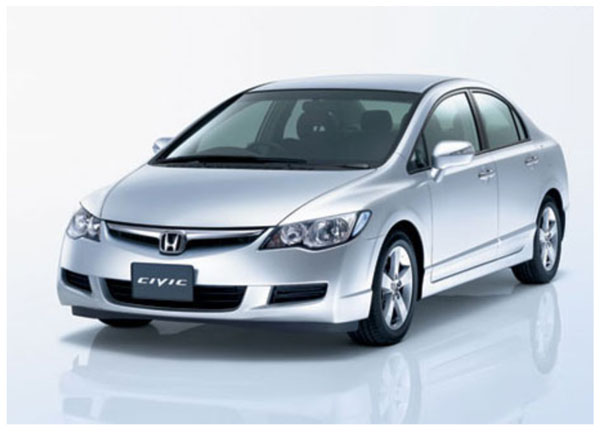
The Honda Civic